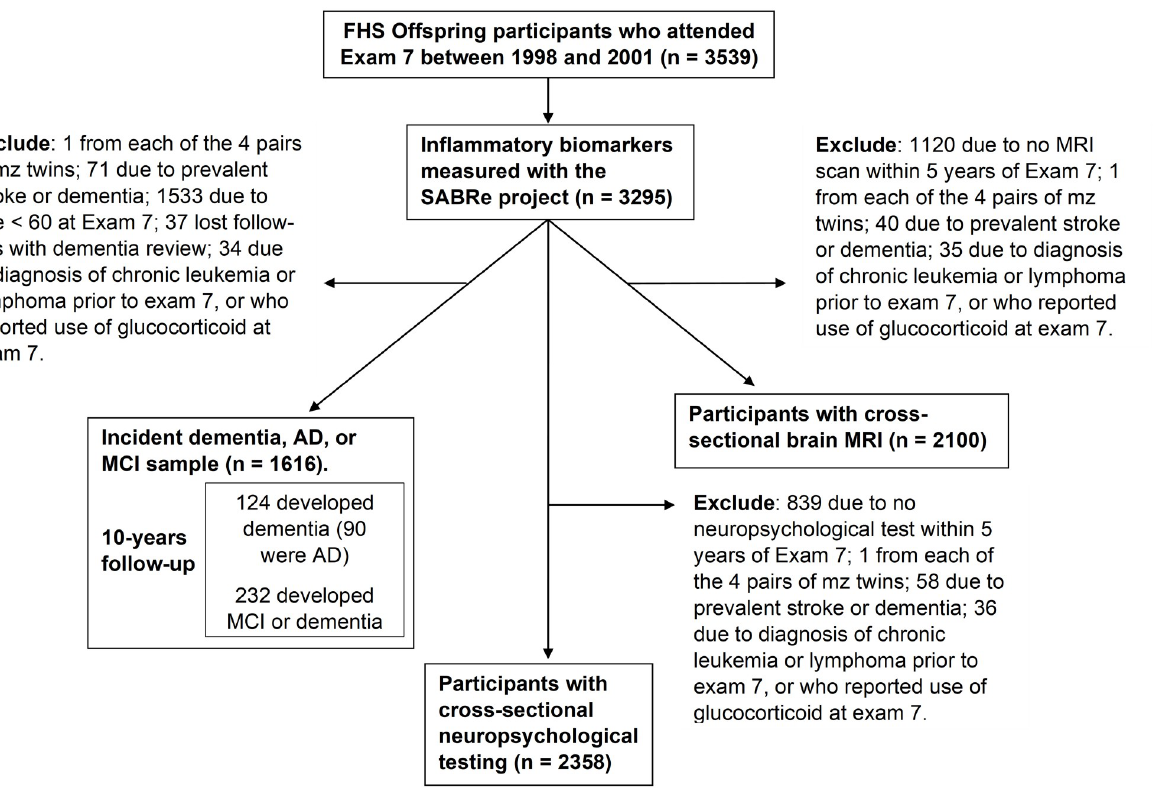
Fig 1. Study sample for the incident dementia, neuropsychological testing and the brain MRI outcomes. The biomarkers were collected from the Offspring cohort examination 7(1998–2001). One from each of 4 pairs of Monozygotic (mz) twins with biomarkers measurements were excluded. Participants with prevalent dementia or stroke, participants diagnosed with chronic leukemia or lymphoma prior to exam 7, and participants who reported use of glucocorticoid medication at exam 7 were excluded from all study samples. A 10-year follow-up window was applied in the study for incident dementia, AD or MCI. The closest neuropsychological testing battery and brain MRI scan within five years of the examination was used.